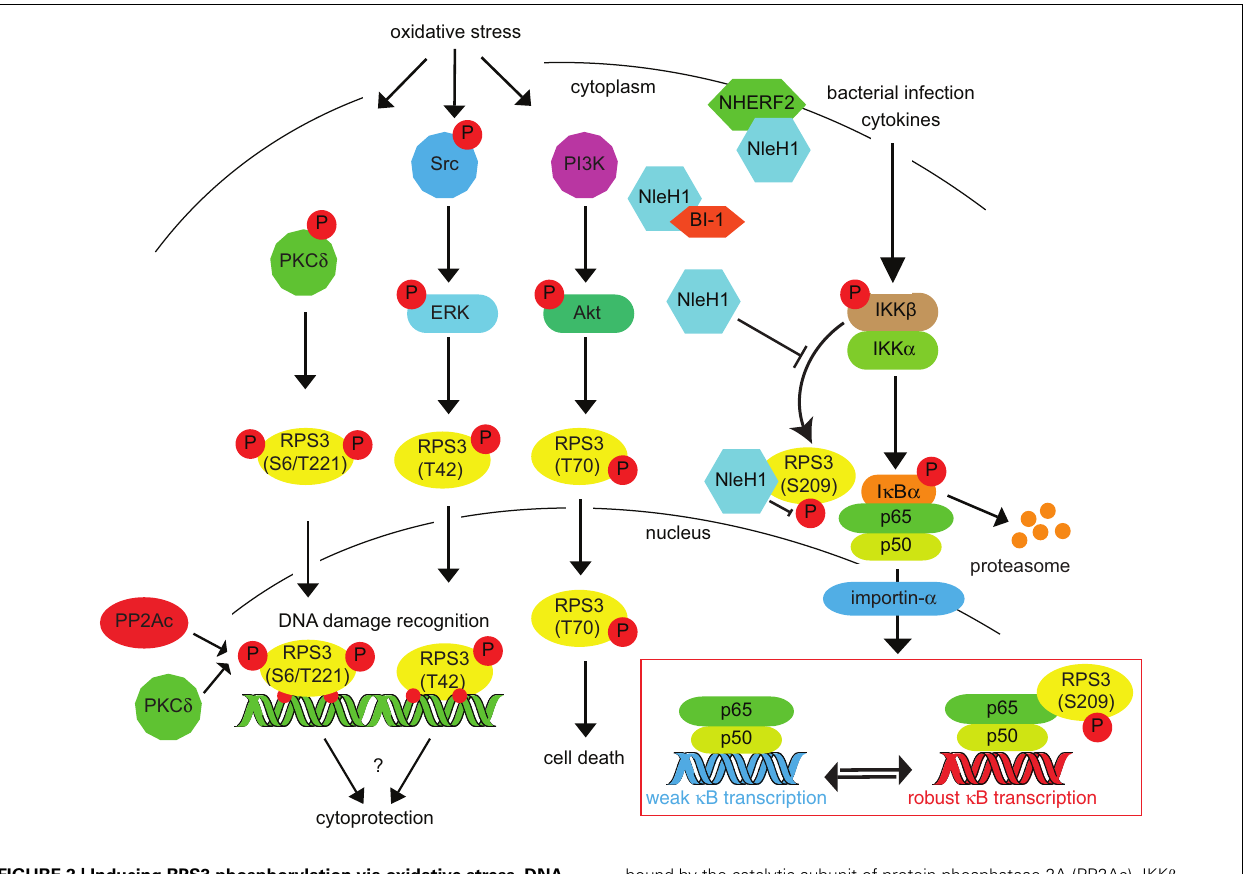
FIGURE 2 | Inducing RPS3 phosphorylation via oxidative stress, DNA damage, and bacterial infection. RPS3 phosphorylation is activated by a variety of cellular stressors.The specific phosphorylation sites and the protein kinases responsible (PKC δ , ERK, Akt) are indicated. Nuclear RPS3 is also